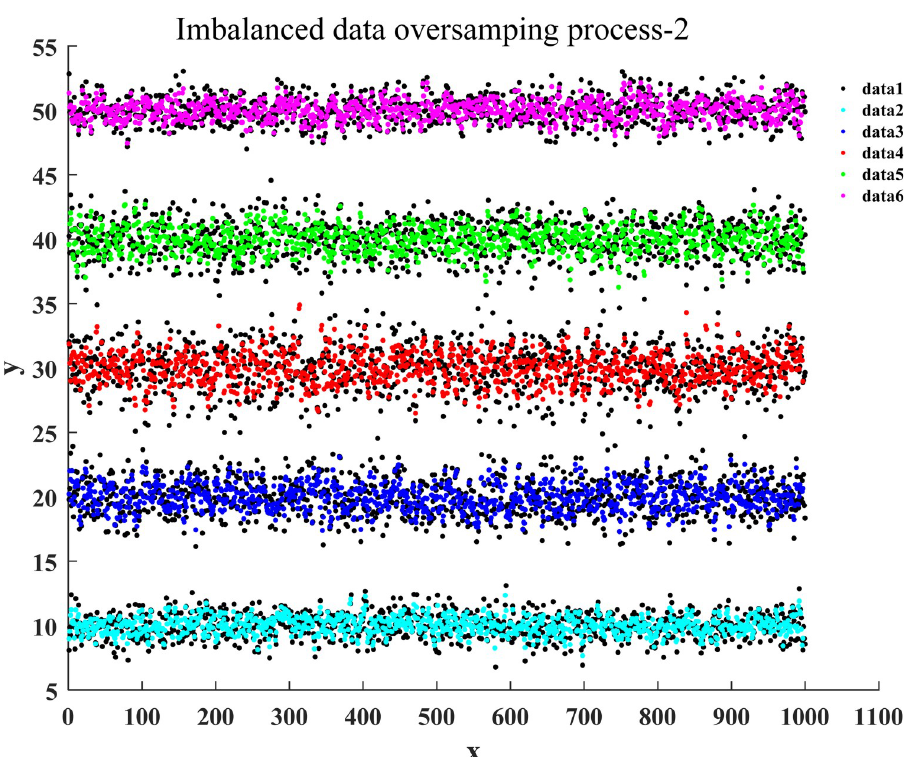
Fig 5. The 2-point sampling of oversampling for imbalanced data.